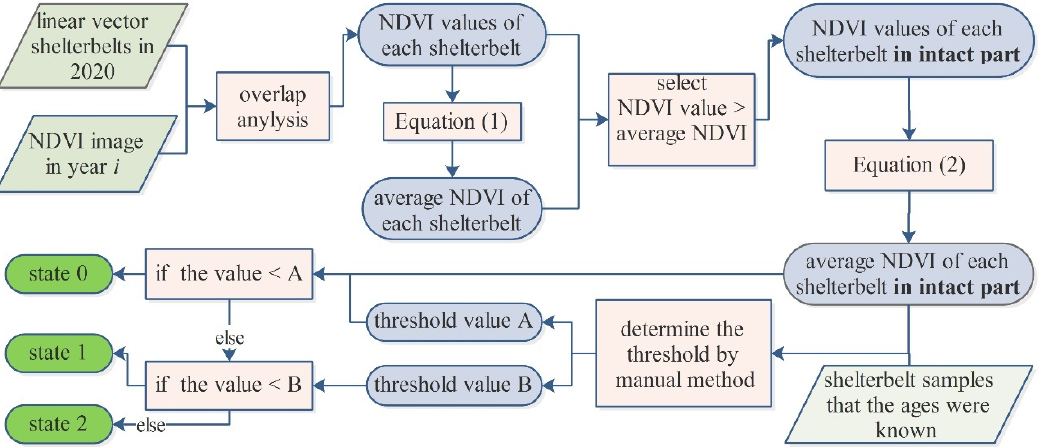
Figure 2. Flowchart of data processing in determining shelterbelt states.